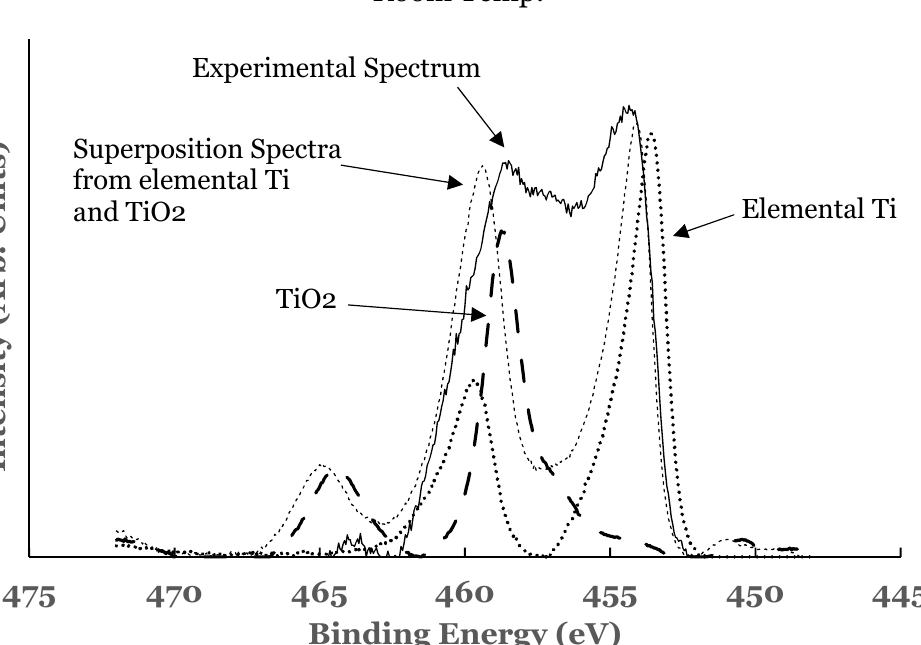
Figure 5. Curve fit for the 2p region of titanium for the 1.1 nm overlayer deposited at room temperature. The thin solid line represents the experimental data. The thick dotted line represents the spectrum from elemental Ti while the thick dashed line that from TiO 2 . The thin dotted line represents the superposition from elemental Ti and TiO 2 .